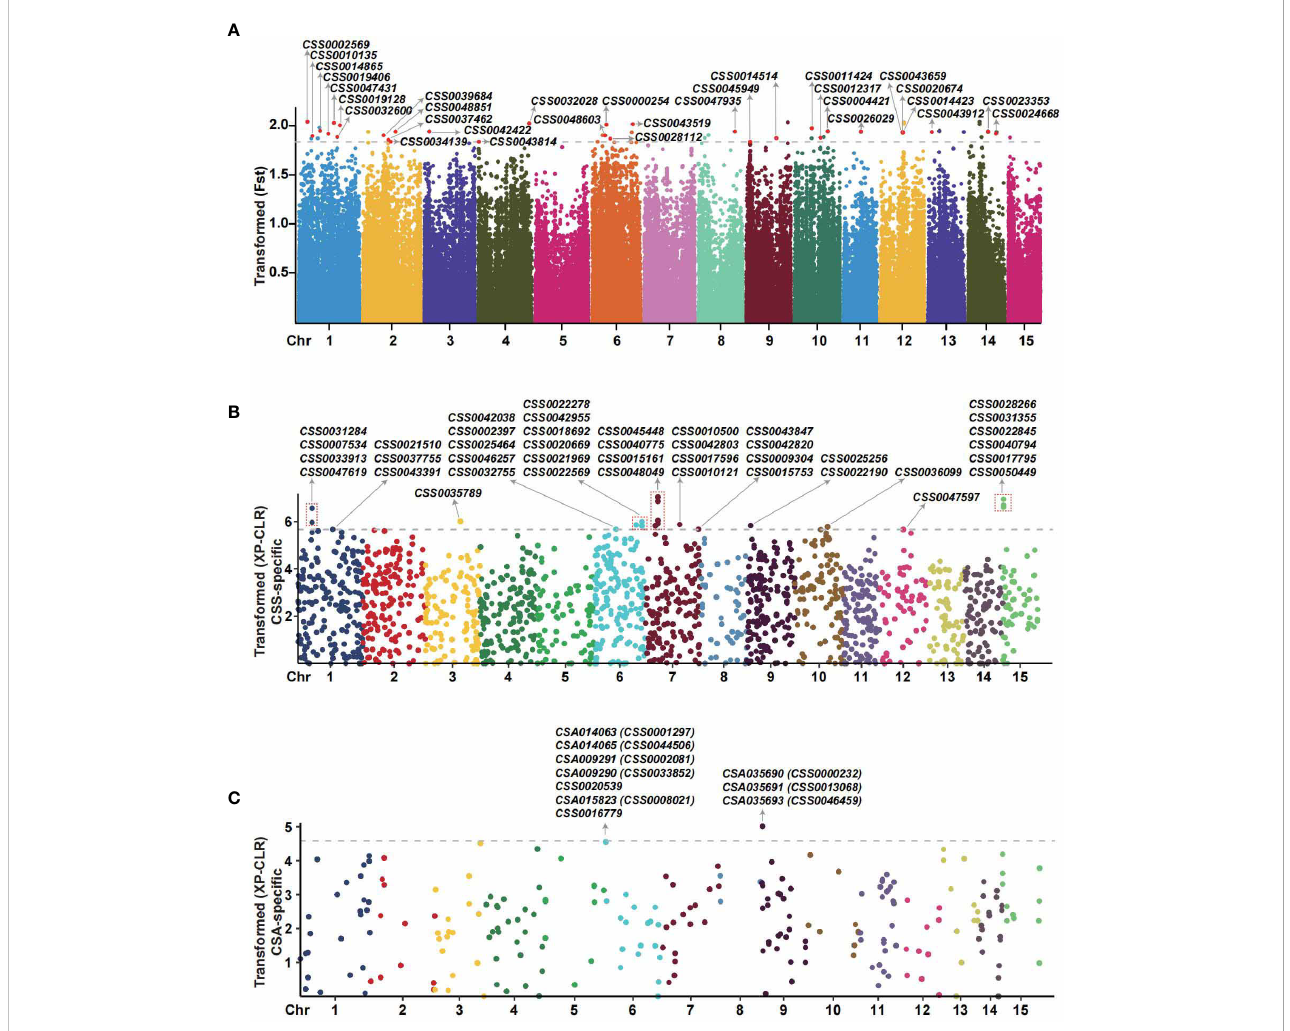
FIGURE 5 Genome-wide scan for positive selection signatures from modern tea cultivars from the coding region by VCFtools and XP-CLR methods. (A) Detection of selection signals based on single loci. The dots of different colors represent SNP sites. The red dots above the grey dashed line represent SNPs with strong positive natural selection signals (top 10% Fst values). Arrows indicate the gene IDs with the detected strong selection signal. The X-axis indicates the chromosome position, and the values of the Y-axis are the transformed fi xation index (Fst). (B) Detection of the CSS-speci fi c positive natural selection genes from multi-locus (genomic blocks). The dots with different colors represent genomic blocks. The dots above the grey dashed line represent genomic blocks with strong positive natural selection signals (top 1% positive XP-CLR values). The X-axis indicates the chromosome position, and the Y-axis is the log-transformed XP-CLR value. (C) The CSA-speci fi c positive natural selection genes were detected from multi-locus (genomic blocks). The dots with different colors represent genomic blocks. The dots above the grey dashed line represent genomic blocks with strong positive natural selection (top 1% positive XP-CLR values). The X-axis indicates the chromosome position, and the Y-axis is the log-transformed XP-CLR value. The BLASTp software was used to identify the orthologs of CSA and CSS with protein sequence identity >